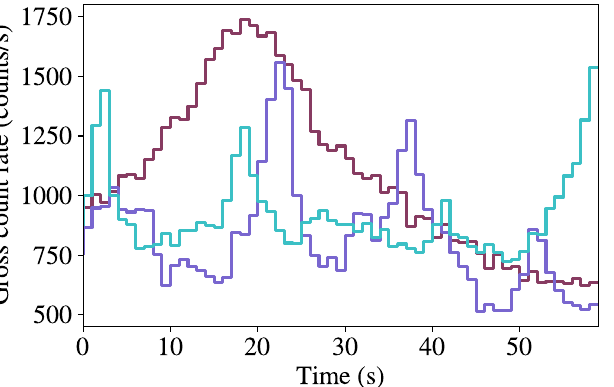
Figure 3. Counts per second as a function of time for the first 60 s of three randomly-sampled runs of background data, illustrating variability in count rates and temporal signatures.